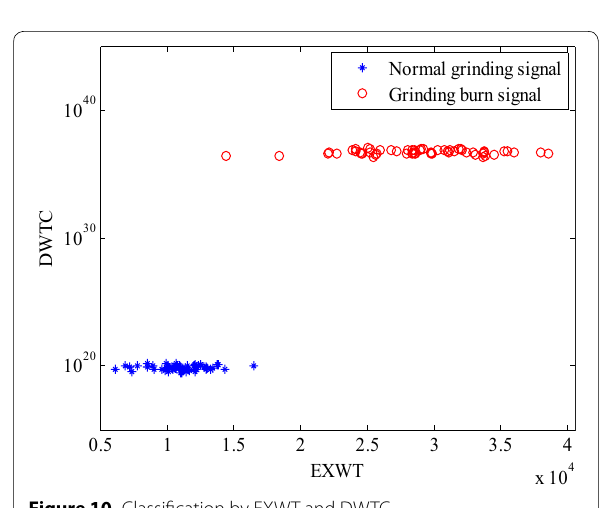
Figure 10 Classification by EXWT and